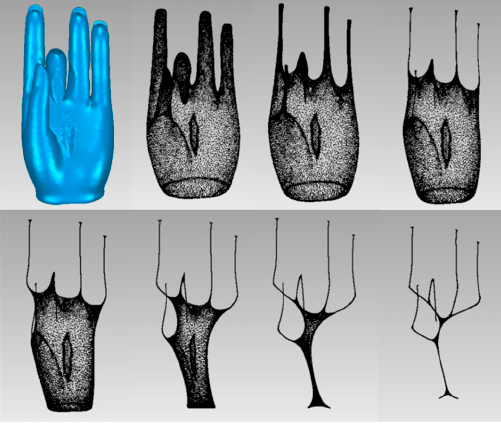
Figure 8. Iteration contraction process of cultural relic model.